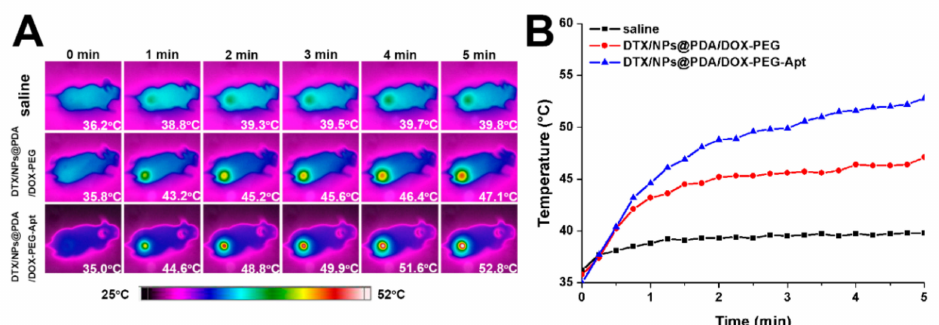
Figure 8. ( A ) IR thermal images of nude mice bearing MCF-7 cells xenograft under photothermal therapy. ( B ) Time-dependent temperature curves of MCF-7 tumor-bearing mice. NIR laser: 808 nm, 1.5 W / cm 2 , 5